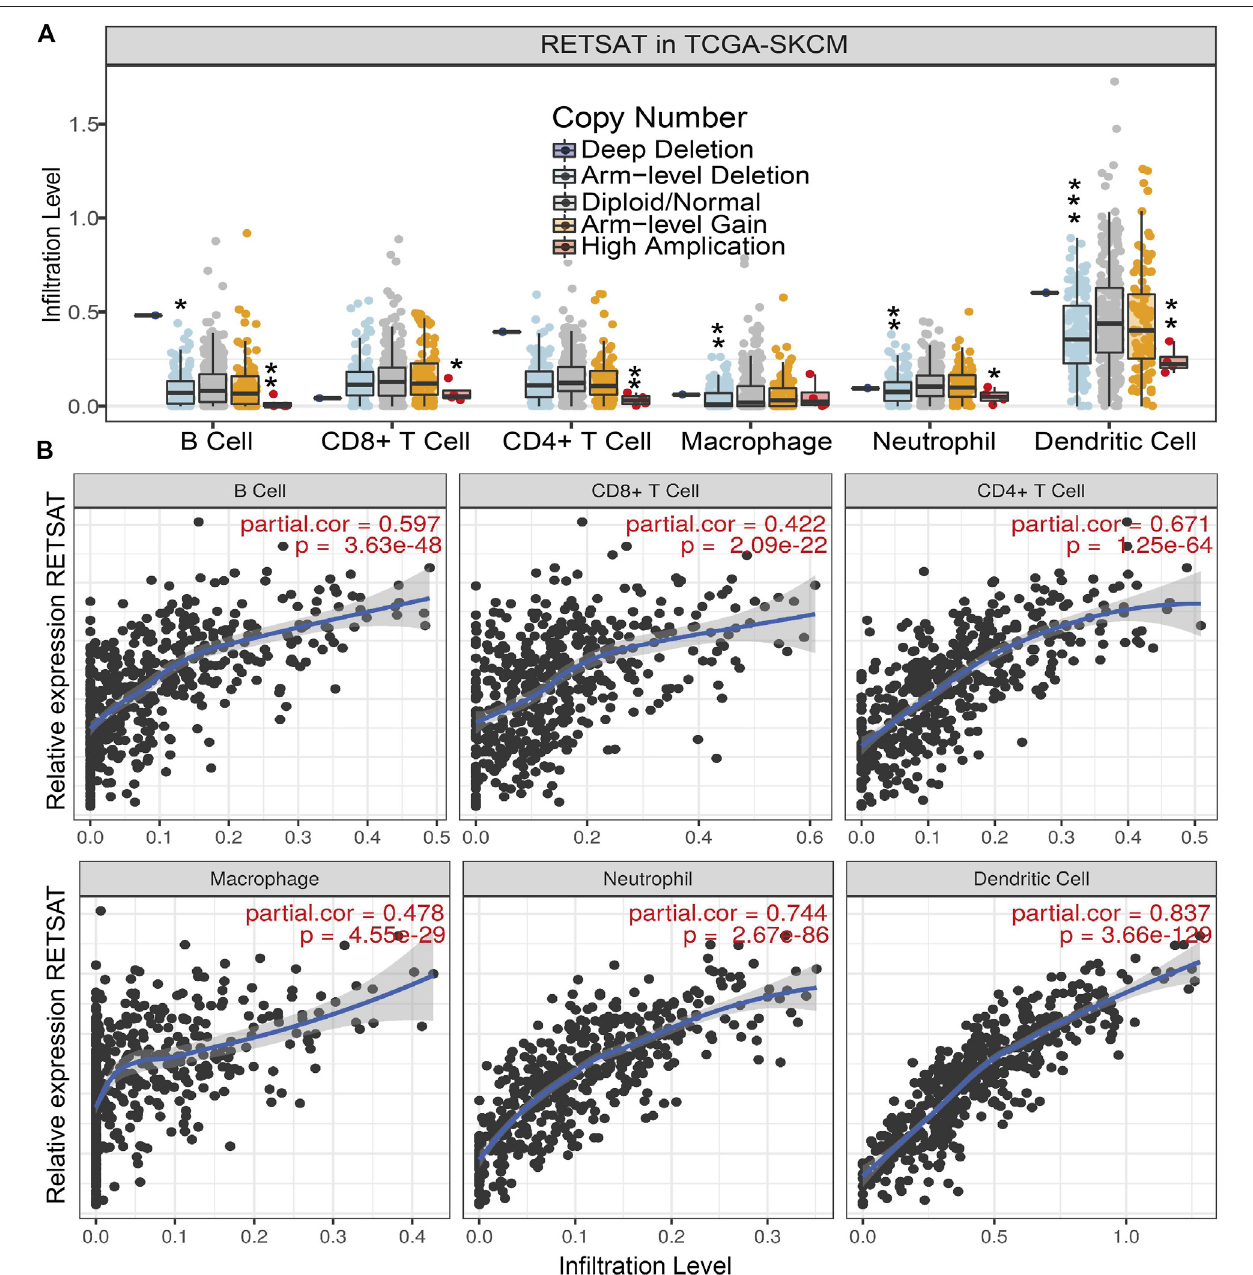
FIGURE 3 | RETSAT correlates with immune cell in fi ltration in tumors. (A) The in fi ltration levels of various immune cells correlate with RETSAT mutations in SKCM usingtheTIMERdatabase. (B) ThecorrelationofRETSATexpressionlevelwithBcell,CD8 + Tcell,CD4 + Tcell,macrophage,neutrophilordendriticcellin fi ltrationlevelin SKCM analyzed by TIMER database. * p < 0.05, ** p < 0.01, *** p < 0.001.